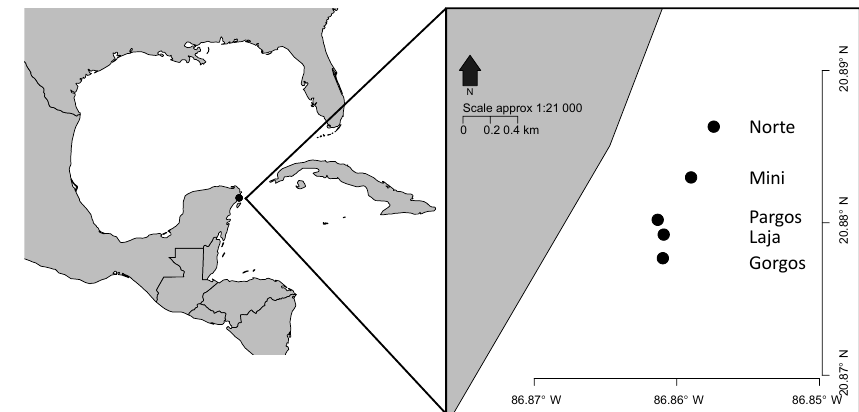
Figure 1. Location of submarine springs at the sampling